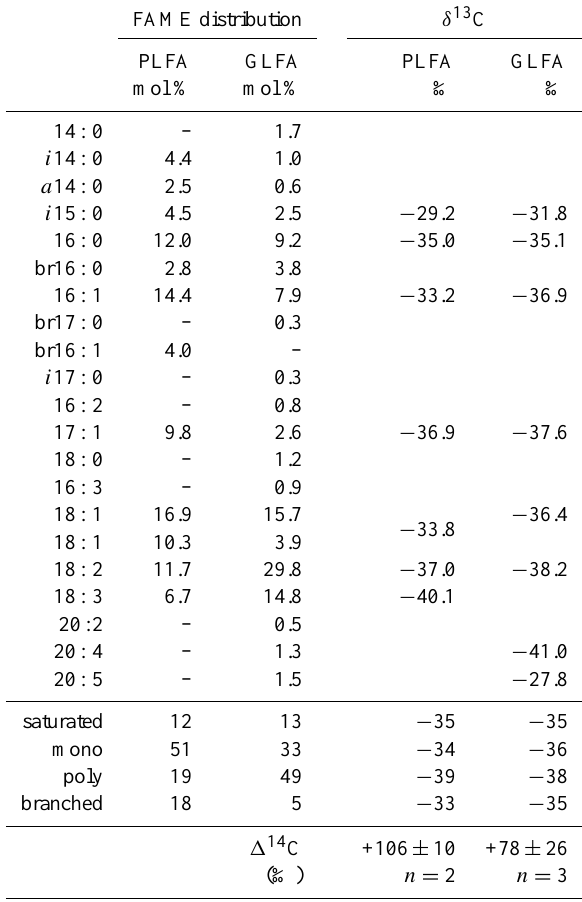
Table 1. Phospholipid and glycolipid fatty acid distribution and sta- ble carbon isotopic composition. The bulk organic carbon composi- tion of the gypsum had a stable carbon isotopic value of − 27.2‰. Uncertainty of δ 13 C measurements was less than ±